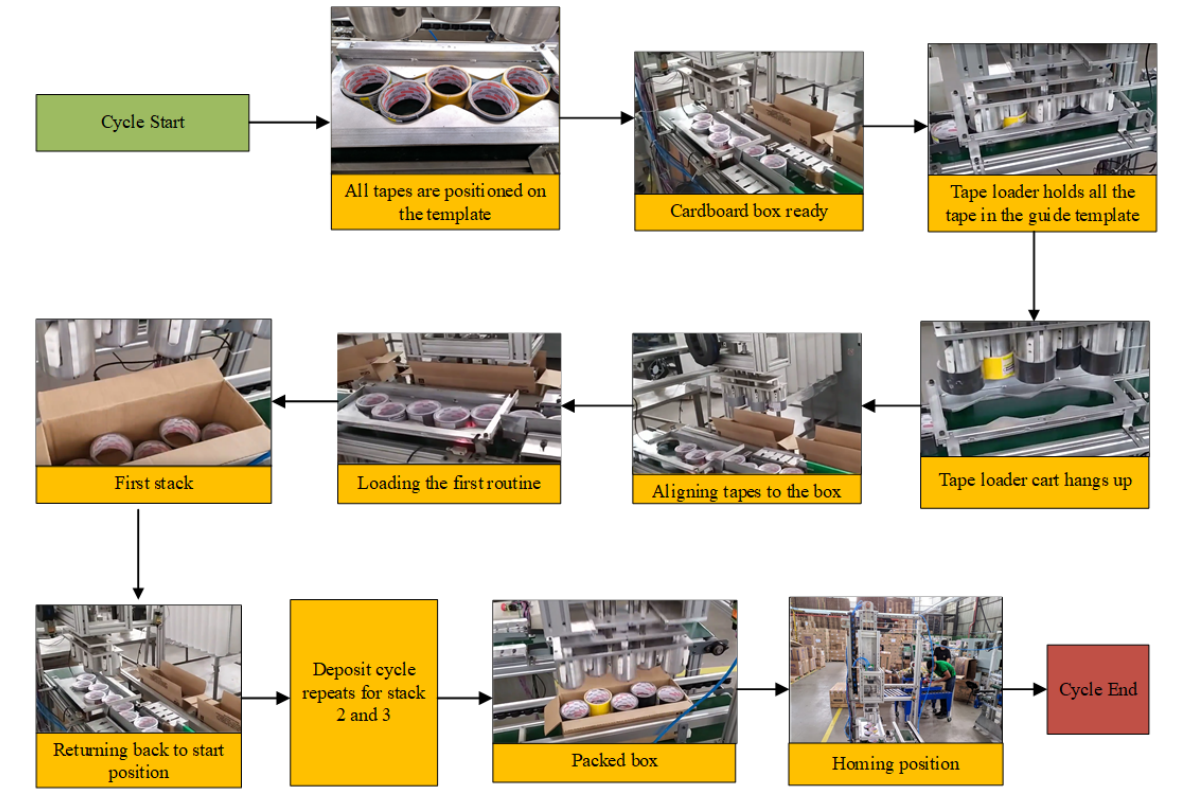
Figure 12. Routine cycle of the Guzzetti packaging machine.